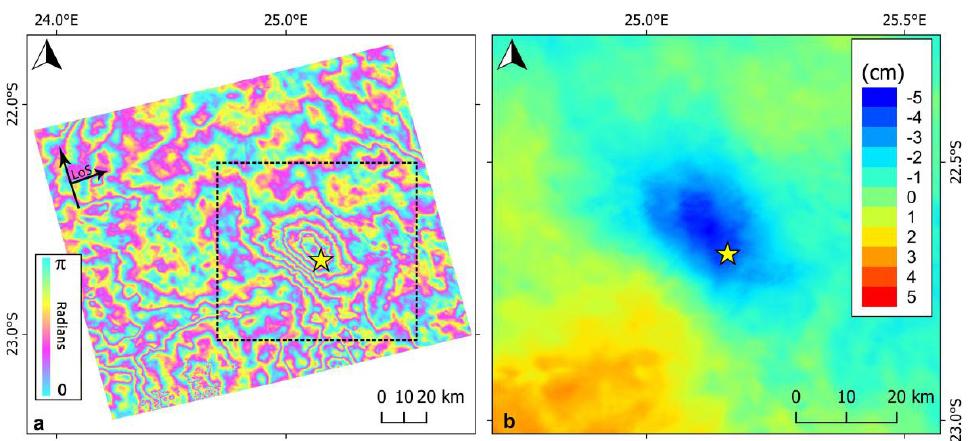
Figure 2. ( a ) Wrapped interferogram showing the co-seismic displacement induced by the M w 6.5, 2017 Botswana earthquake. The interferogram’s footprint corresponds to the blue rectangle in Figure 1b). The interferogram was re-wrapped with a color scale ranging from 0 and π then each color cycle represents a LoS deformation of approximately 1.40 cm (i.e., λ/4). ( b ) Detail of the area bordered by the dashed black square in panel ( a ), showing the unwrapped interferogram. The yellow star indicates the earthquake epicenter (https://earthquake.usgs.gov/earthquakes/eventpage/us10008e3k#executive). Coordinates are in the wgs84 datum.